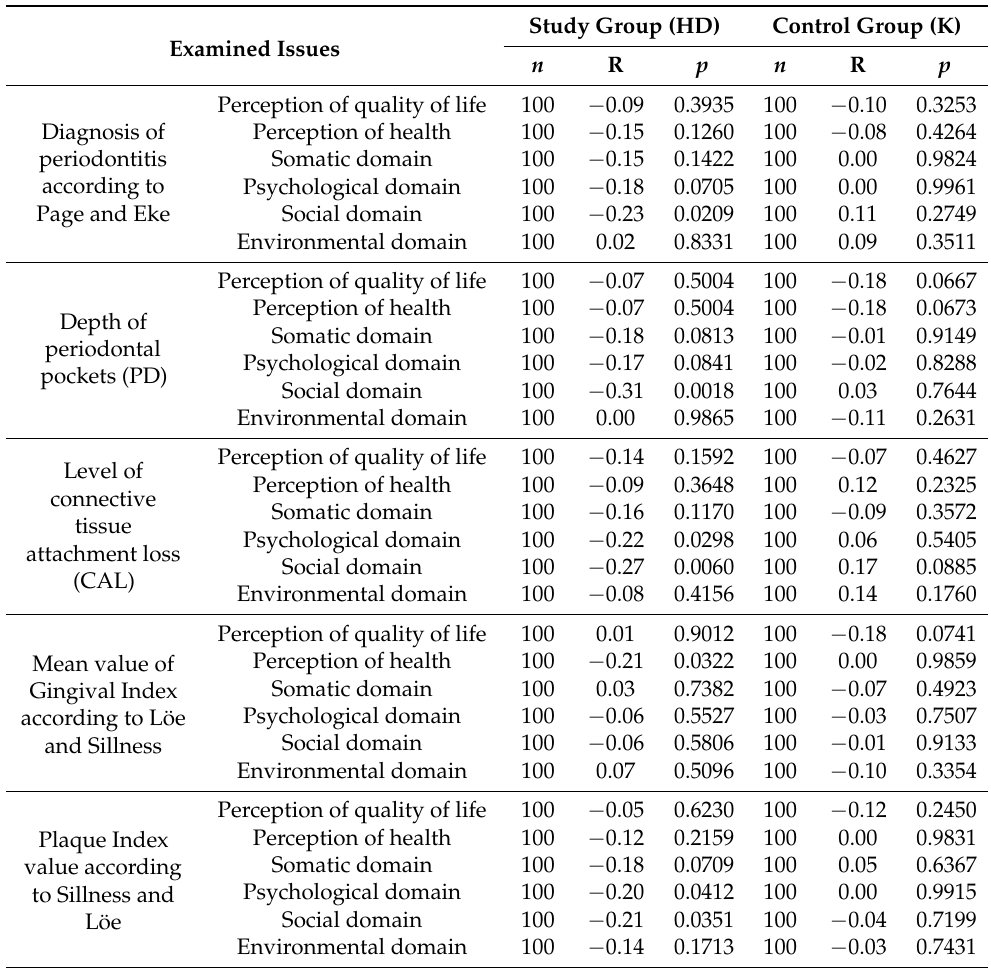
Table 6. Quality of life vs. periodontitis diagnosis according to Page and Eke [26], periodontal status and oral hygiene parameters (PD, CAL, GI, PI) in the study groups (HD,